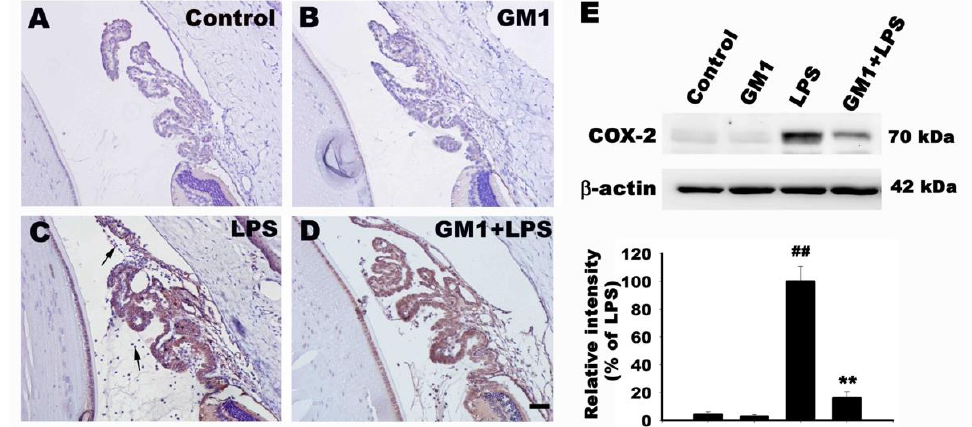
Figure 4. Effect of GM1 on COX-2 expression in the anterior segment of rats with EIU. Rats were pretreated with GM1 and then treated with or without LPS for another 24 h. Representative images of COX-2 immunohistochemical staining in sections from the four different treatment groups: vehicle control ( A ), GM1 alone ( B ), LPS ( C ) and GM1+LPS ( D ) at 24 h after the LPS injection. Note that abundant COX-2-positive inflammatory cells infiltrated the ICB of rats with EIU (arrows in C), and this inflammatory response was attenuated by GM1. ( E ) Western blot analysis of COX-2 levels. The protein bands from each treatment group were quantified by densitometry. GM1 significantly reduced the LPS-induced increase in COX-2 expression in the anterior segment of rats. Data are presented as percentages of the LPS-treated group (mean ± S.D., n = 3). ## p < 0.01 compared with the control group; ** p < 0.01 compared with the LPS-treated group. Bar = 50 µ m.